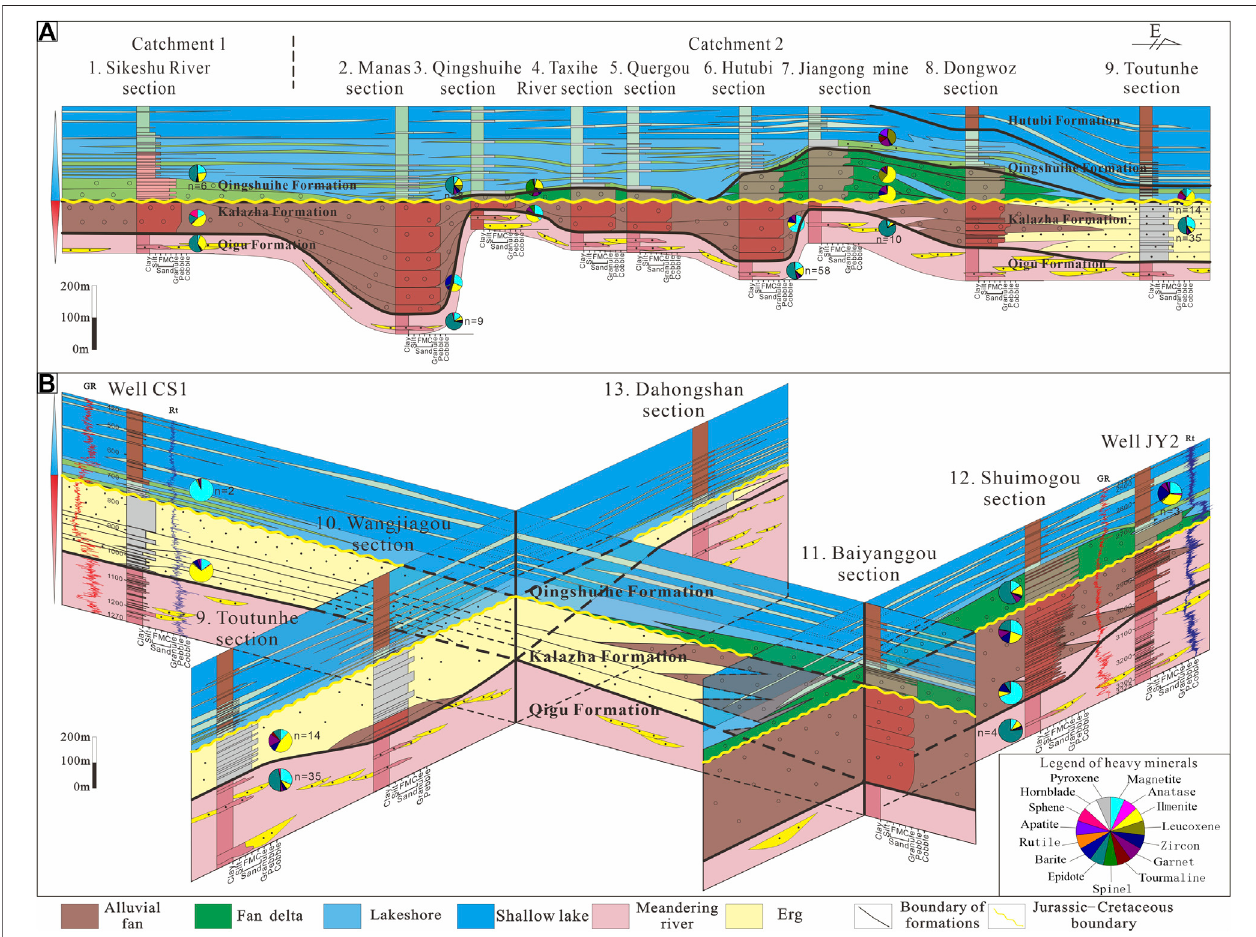
FIGURE 8 | Sedimentary comparison and heavy mineral assemblages in the northern piedmont of the Tianshan (A) and Bogda Orogenic Belts (B) in the late Mesozoic in the Southern Junggar Basin.